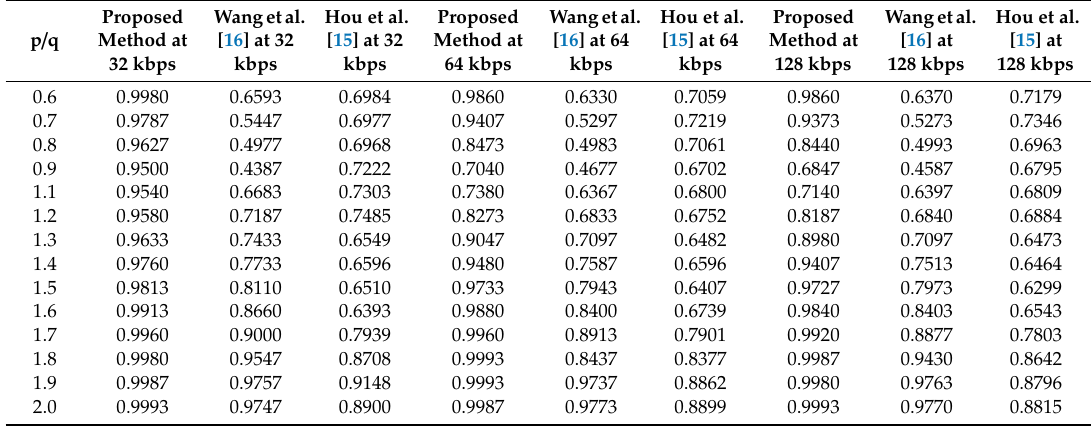
Table 5. Detection results under di ff erent compression bit